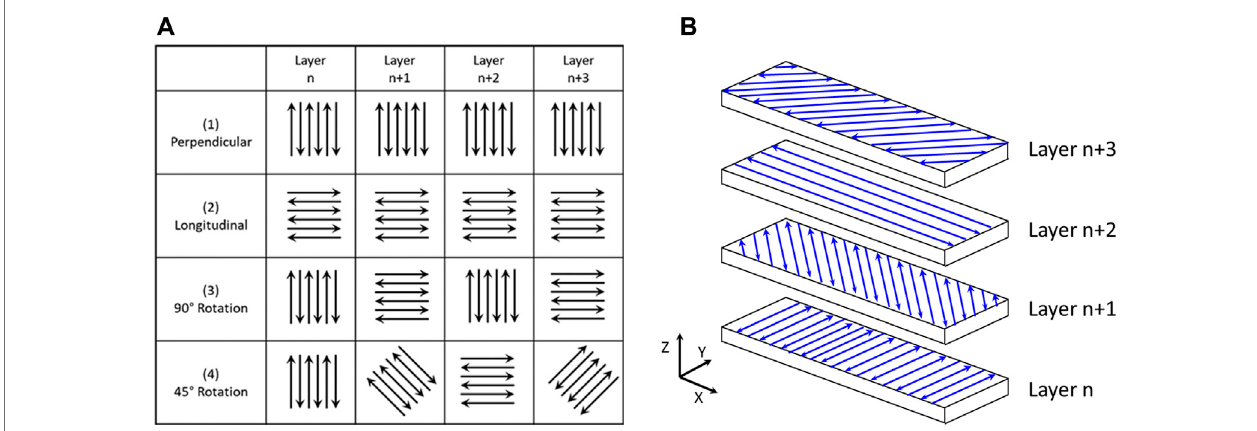
FIGURE 1 | (A) The four different printing patterns used to compare the HL models with experimental results. The perpendicular and longitudinal patterns have short(0.5 mm)andlong(5 mm)vectorlengthswithzerorotationanglebetweenthelayers.The90 ° and45 ° rotationspatternshavecounterclockwiserotationofthelaser direction after each layer. (B) An example of the 45 ° rotation pattern is given for four